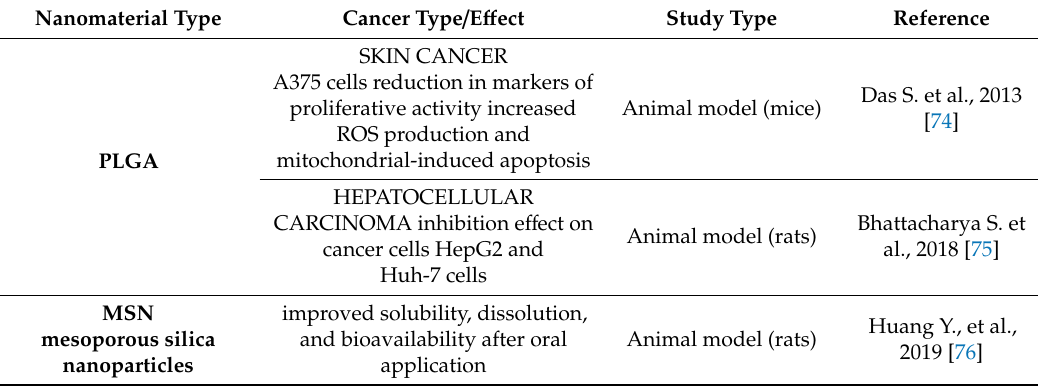
Table 5. Anticancer e ff ect of apigenin nanoparticles in in vivo